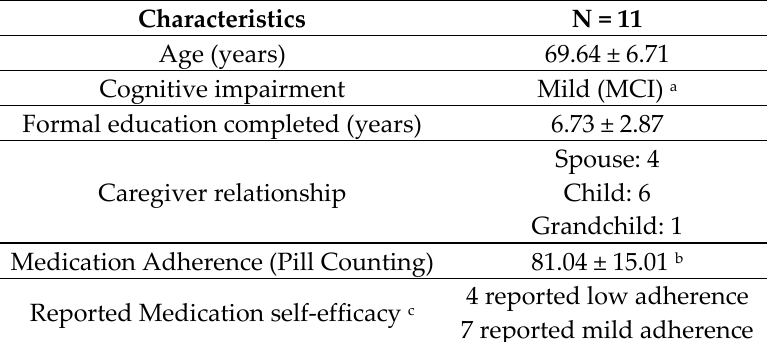
Figure 5. Cumulative pill-count adherence across the 12 weeks of evaluation 2. Table 1. Characteristics of the older adults (N = 11) who used